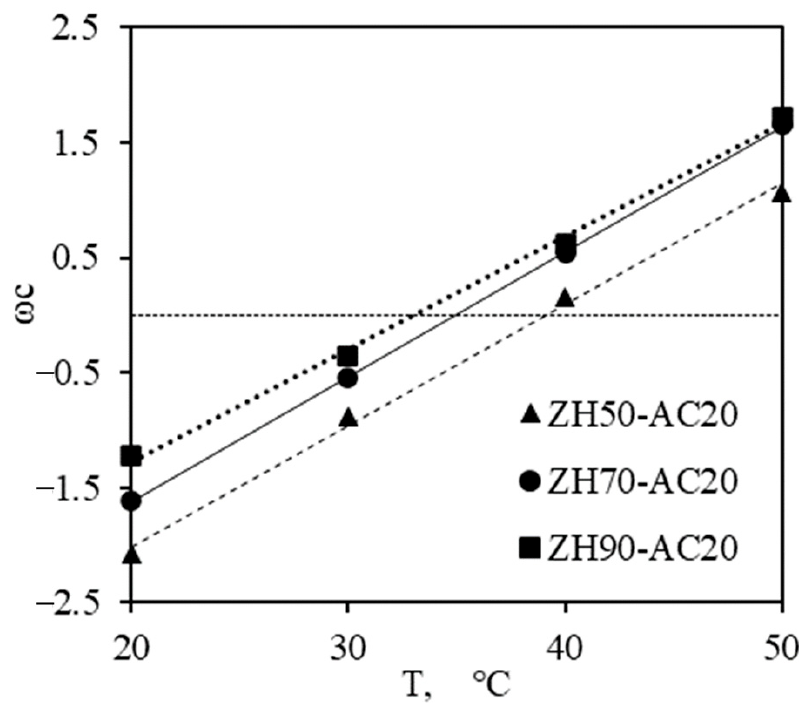
Figure 8. Relationship between ω c and temperature.